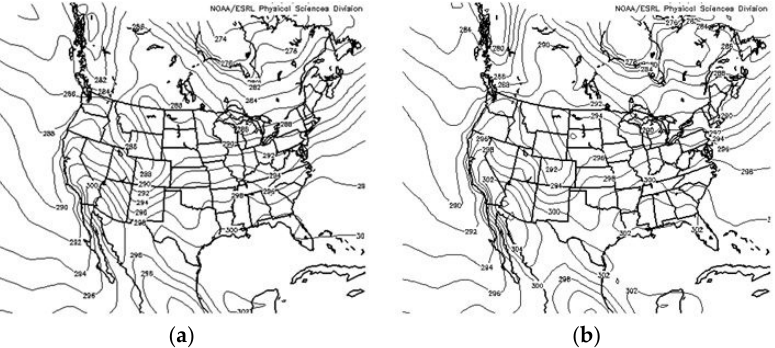
Figure 7. Precipitable water (shaded; every 2 kg·m − 2 from) 20 to 50: ( a ) composites for elevated convection; and ( b ) composites for surface based convection.